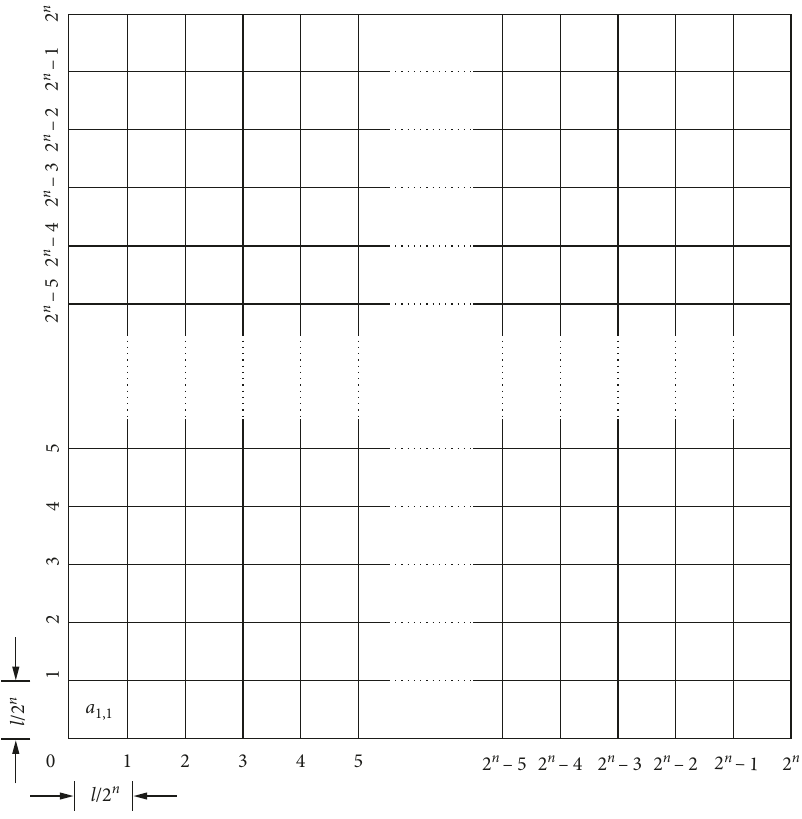
Figure 2: Random field cell values represented by matrix